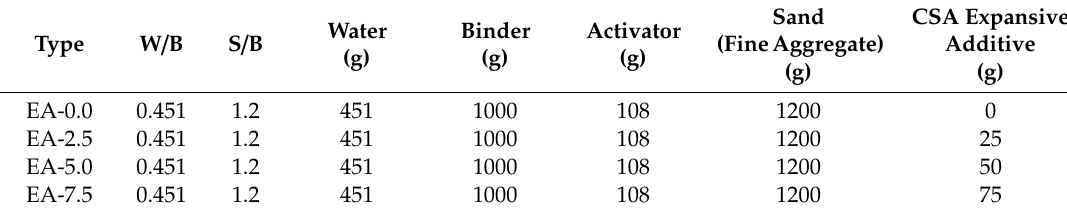
Table 2. Mix proportions of alkali-activated material (AAM)